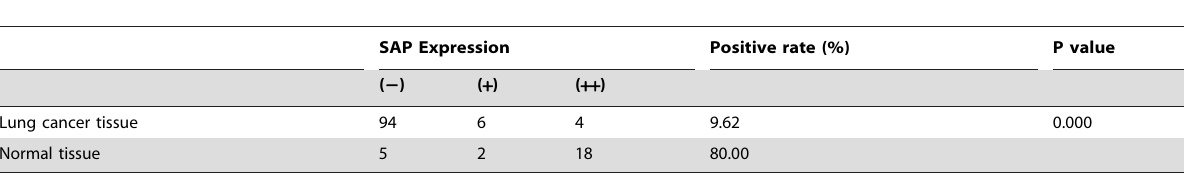
Table 2. Expression of SAP in lung cancer and normal tissues.